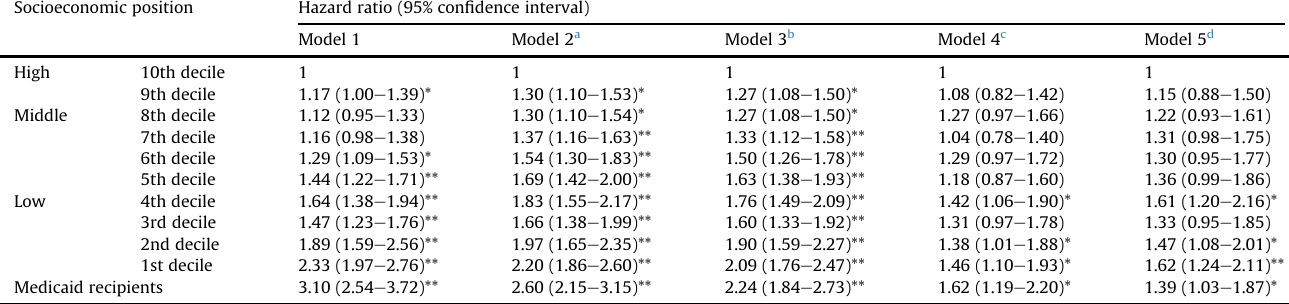
Table 3 Hazard ratios across socioeconomic positions. Socioeconomic position